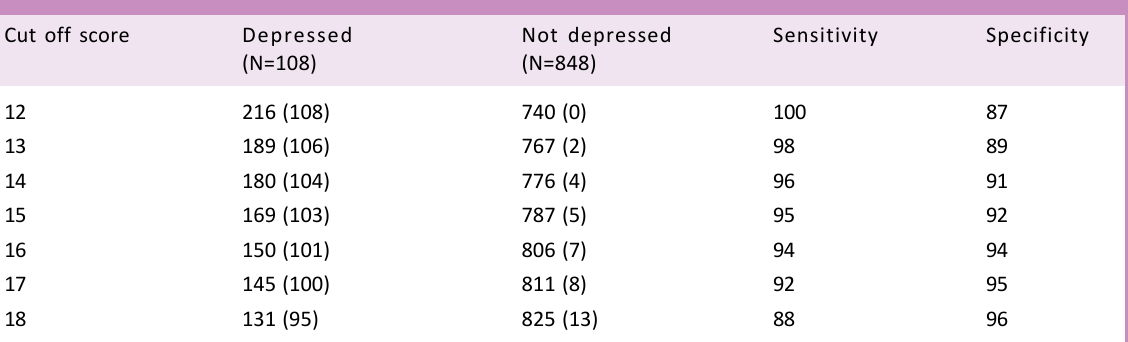
Table 3. Sensitivity and specificity for each cut-off scores Cut off